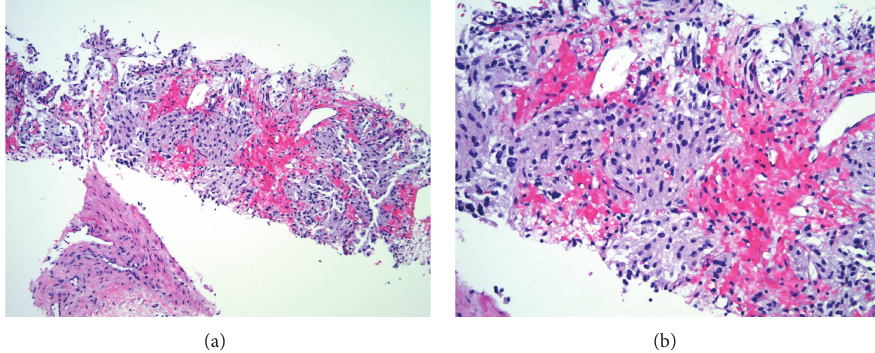
Figure 2: Microscopic examination of renal biopsy specimen in 100x view (a) and 200x view (b) showing cellular epithelioid proliferation arranged in nests and composed of round to ovoid cells with hyperchromatic nuclei, inconspicuous nucleoli, and granular amphophilic cytoplasm.